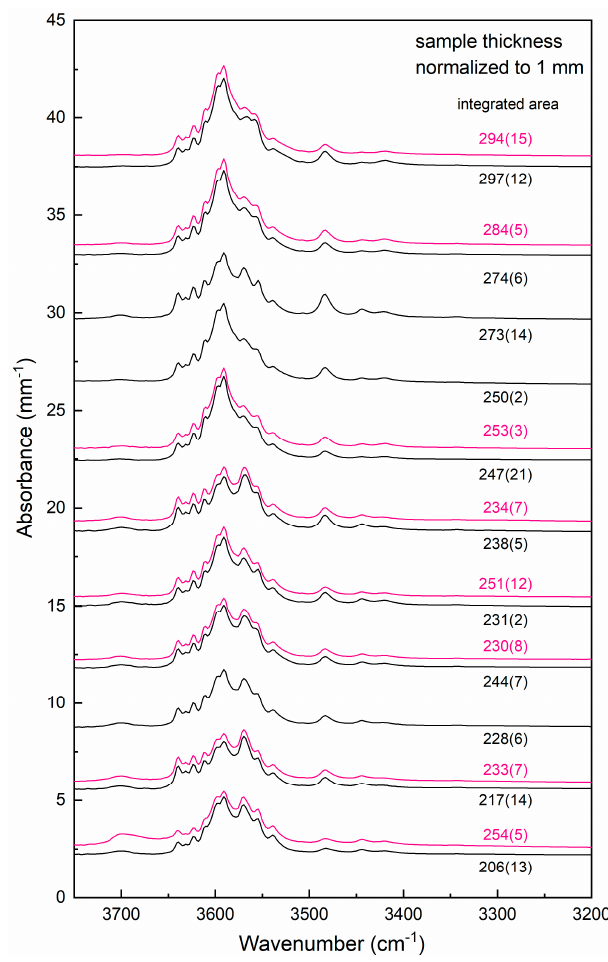
Figure 11. Unpolarized infrared spectra of the forsterite in jianite. Each pair of IR spectra is from one forsterite crystal (or fragment), with the spectrum in black representing the central position and the spectrum in pink representing the rim position. Numbers next to the IR spectrum is the integrated absorbance for the region 3750–3200 cm − 1 , with the numbers in the parentheses representing one standard deviation (294(15) read as 294 ± 15).